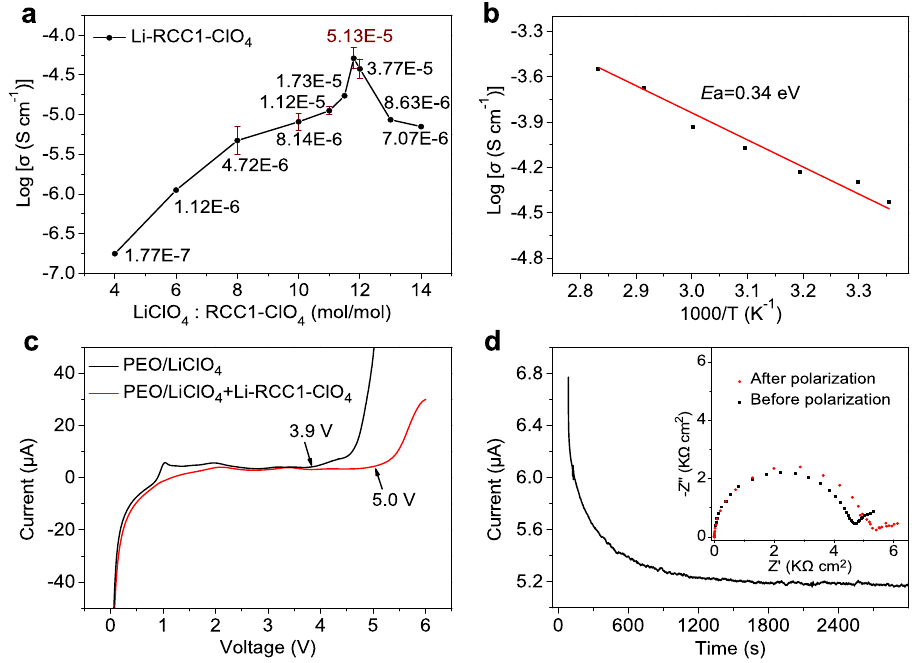
Fig. 2 Electrochemical characterization of Li-RCC1-ClO 4. a Ion conductivity of the Li-RCC1-ClO 4 SSE with different LiClO 4 contents. b Ion conductivity of Li-RCC1-ClO 4 as a function of temperature. c Linear sweep voltammetry (LSV) results of PEO/LiClO 4 and PEO/Li-RCC1-ClO 4 at a scan rate of 1 mV s − 1 . d Time-dependent current before and after direct-current (DC) polarization (with a DC voltage of 50 mV). The insert image shows the EIS results of Li-RCC1-ClO 4 symmetric cell before and after